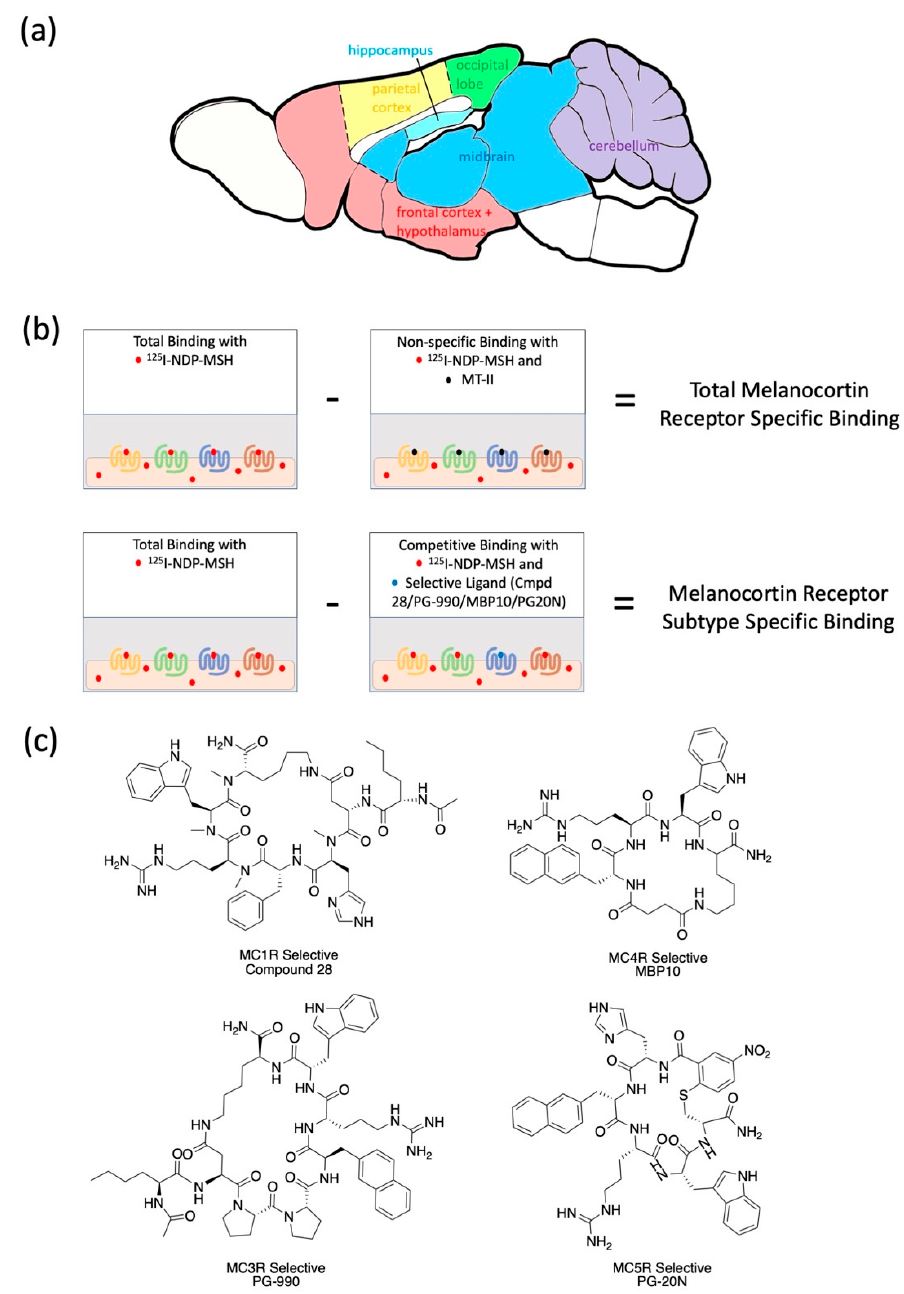
Figure 1. The methods and data processing of [ 125 I]-NDP-MSH radioligand binding assay to de- termine the total and subtype specific melanocortin receptor binding in different rat brain regions. ( a ) A sagittal view of a rat brain showing the six different regions of frontal cortex + hypothalamus, parietal cortex, occipital cortex, hippocampus, midbrain and cerebellum that were studied in this study. ( b ) Schematic of the [ 125 I]-NDP-MSH radioligand binding assays to determine the total and subtype specific melanocortin receptor binding in different brain regions of rats. ( c ) Melanocortin receptor subtype selective ligands (Compound 28, MC1R selective ligand [33] ; PG990, MC3R selec- tive ligand [34] ; MBP10, MC4R selective ligand [35] ; PG20N, MC5R selective ligand [36] used to determine subtype specific melanocortin receptor binding). Comparing between young (6 mo) and aged (23 mo) rats, the aged rats have signifi- 108 cantly lower levels of MCR expression in the occipital lobe, the hippocampus and the mid- 109 brain. 110